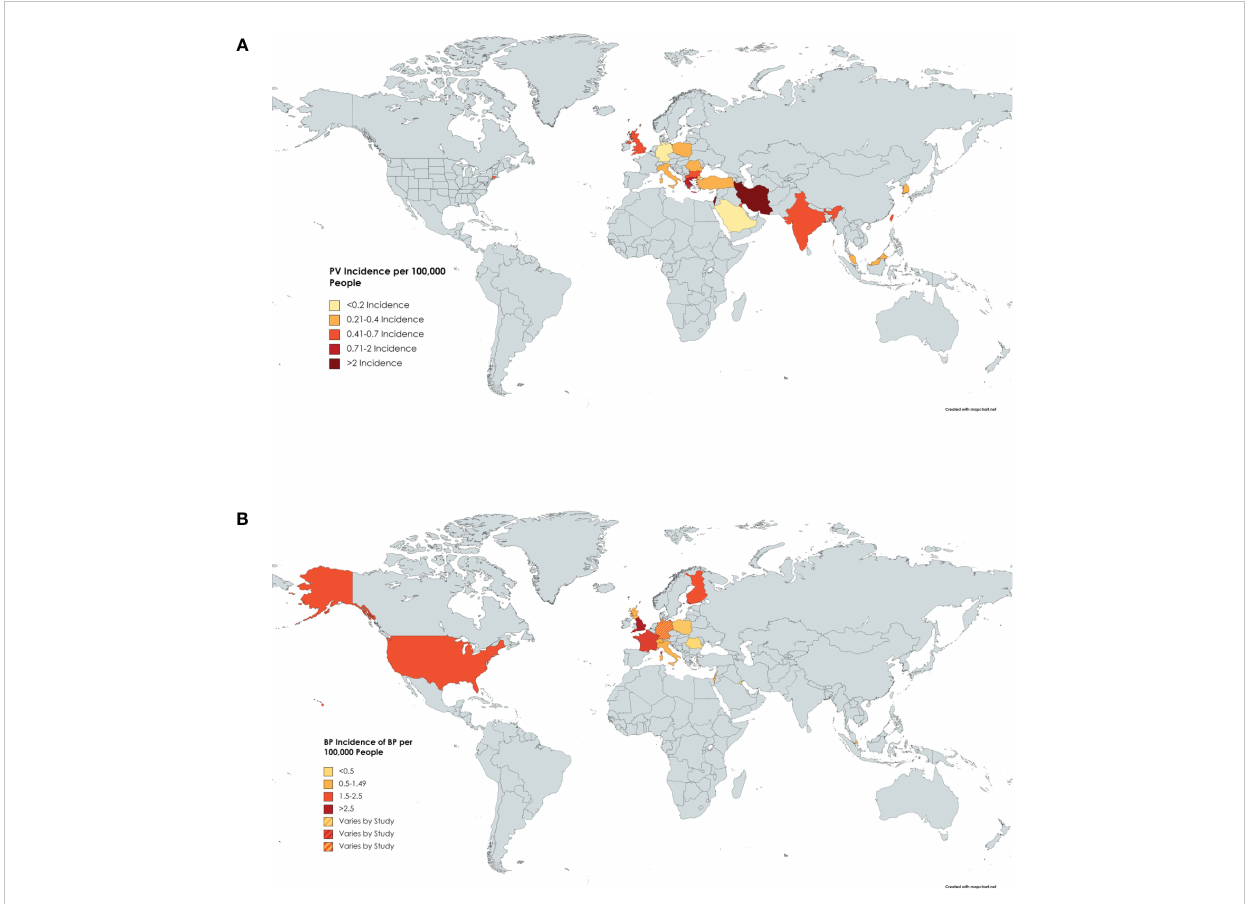
FIGURE 2 Incidence of PV by Country. (A) Darker shading of countries signi fi es higher incidence of pemphigus vulgaris. Speci fi c incidence values can be found in Table 2A. (B) Darker shading of countries signi fi es higher incidence of BP. Speci fi c incidence values can be found in Table